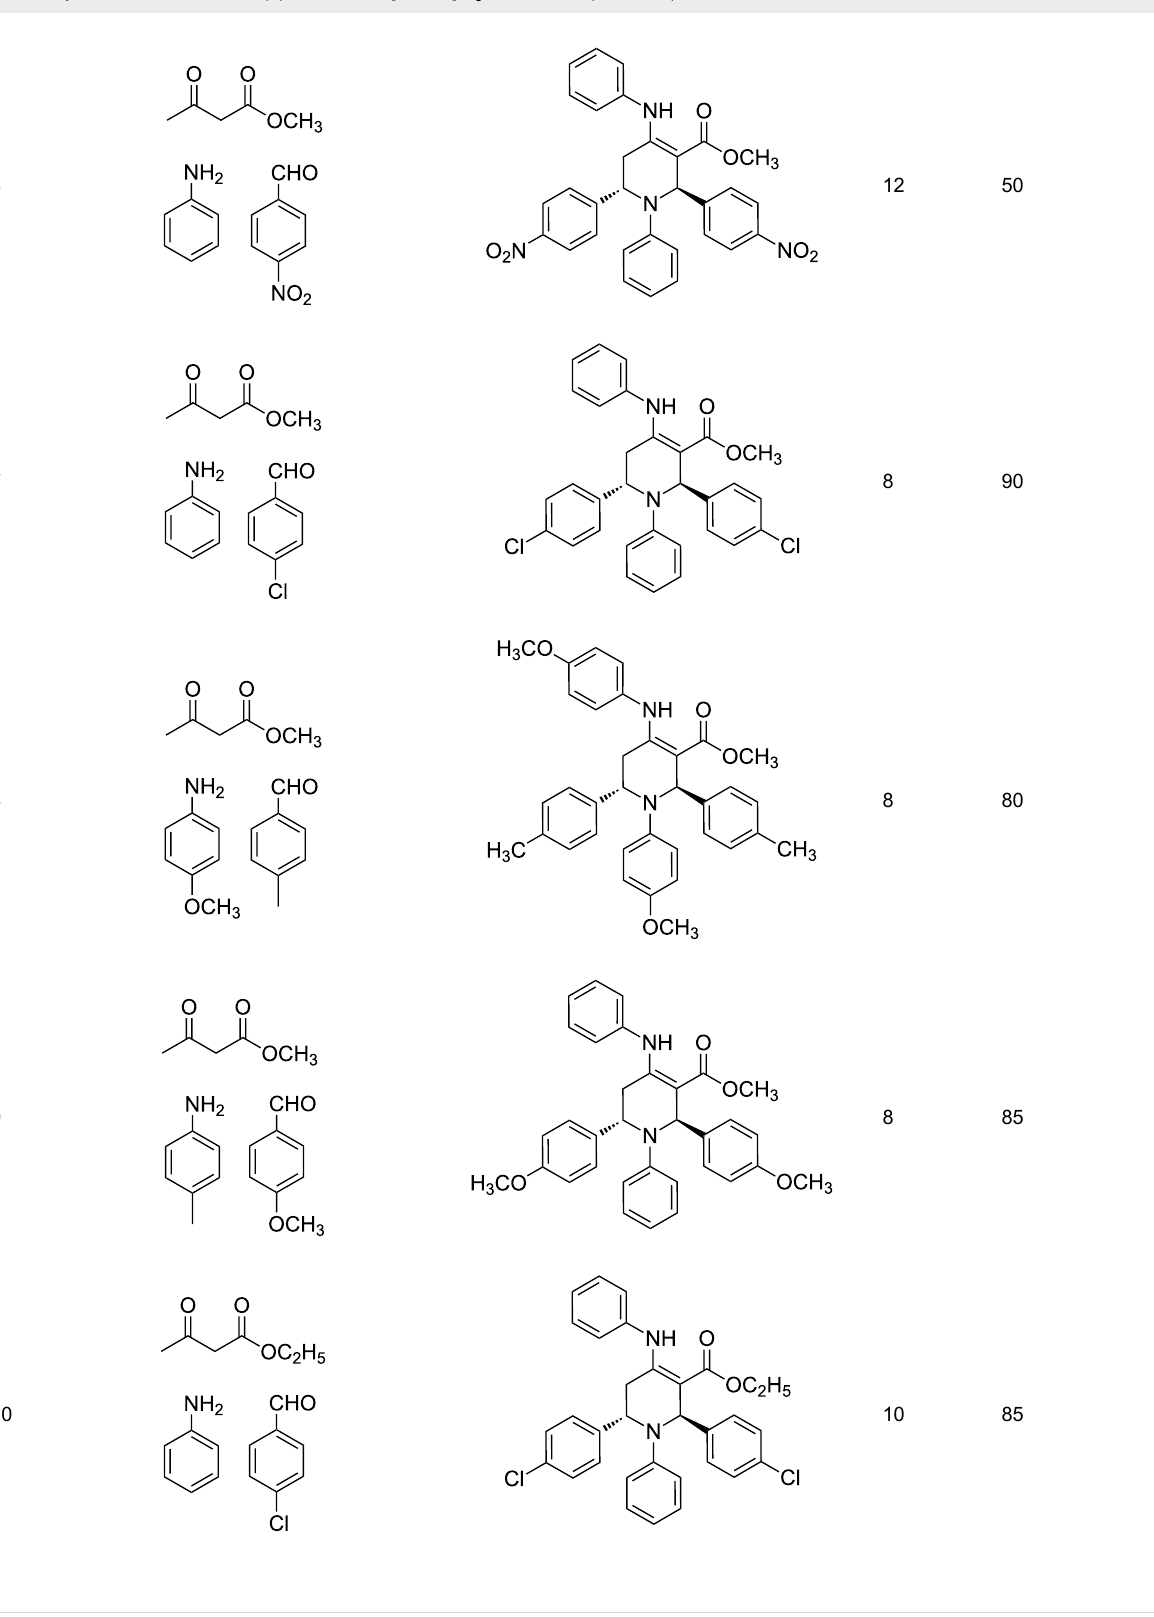
Table 1: Synthesis of functionalized piperidines with [K + PEG]Br 3 − in ethanol. a